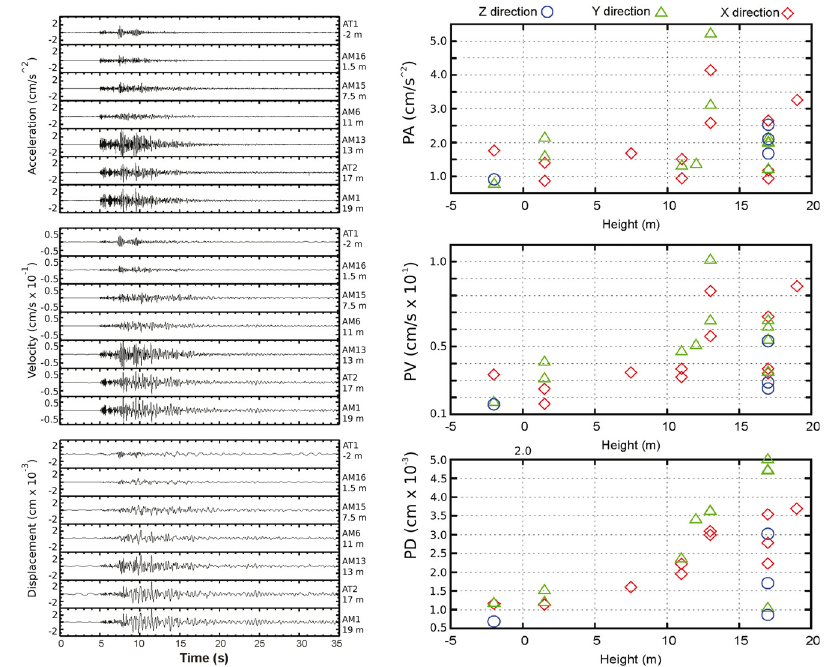
Figure 9a. Earthquake of 30 th October 2012 (M 3.6). Left panel: acceleration, velocity and displacement of some stations at increasing ele- vation (the name of station with elevation is also indicated in the graphs). Right panel: PA, PV and PD versus the station elevation for the three components of